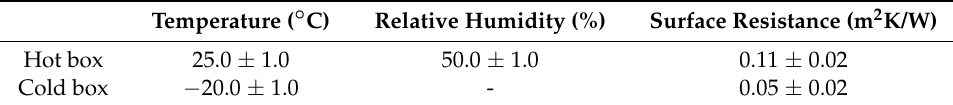
Table 11. Boundary conditions for the TDR test in accordance with KS F